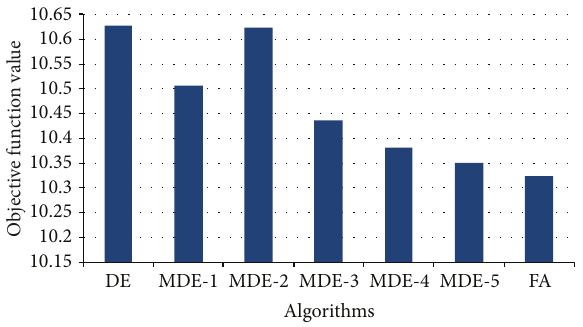
Figure 5: Best results obtained, for the IEEE 6-bus model, by different techniques are compared with the firefly algorithm.